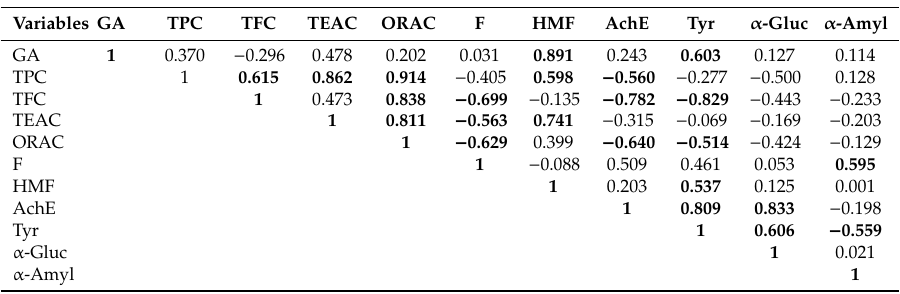
Table 3. Correlation matrix (Pearson correlation coe ffi cients) among gallic acid (GA), total phenolic (TPC) and flavonoid (TFC) contents, antioxidant capacity [Trolox equivalent antioxidant capacity (TEAC) and oxygen radical absorbance capacity (ORAC) methods], furfural (F), 5-hydroxymethyl furfural (HMF), and enzyme [acetylcholinesterase (AChE), tyrosinase (Tyr), α -glucosidase ( α -gluc) and α -amylase ( α -amyl)] inhibitory